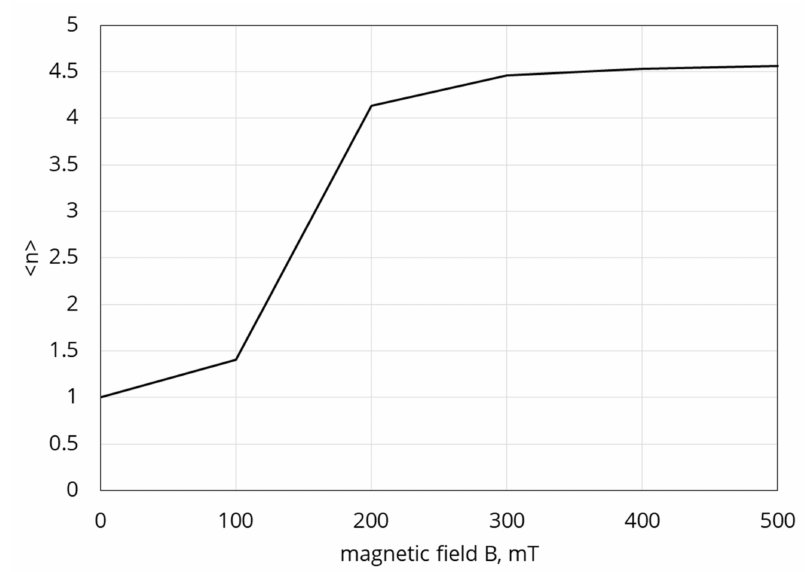
Figure 16. The mean number < n > of agglomerates in the chains vs. applied magnetic field induction B . System parameters: χ 0 = 300, G 0 = 10 kPa, M s = 820 k A